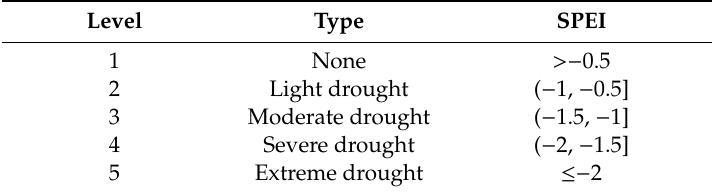
Table 2. Standardized Precipitation Evapotranspiration Index (SPEI) drought classification for drought events.